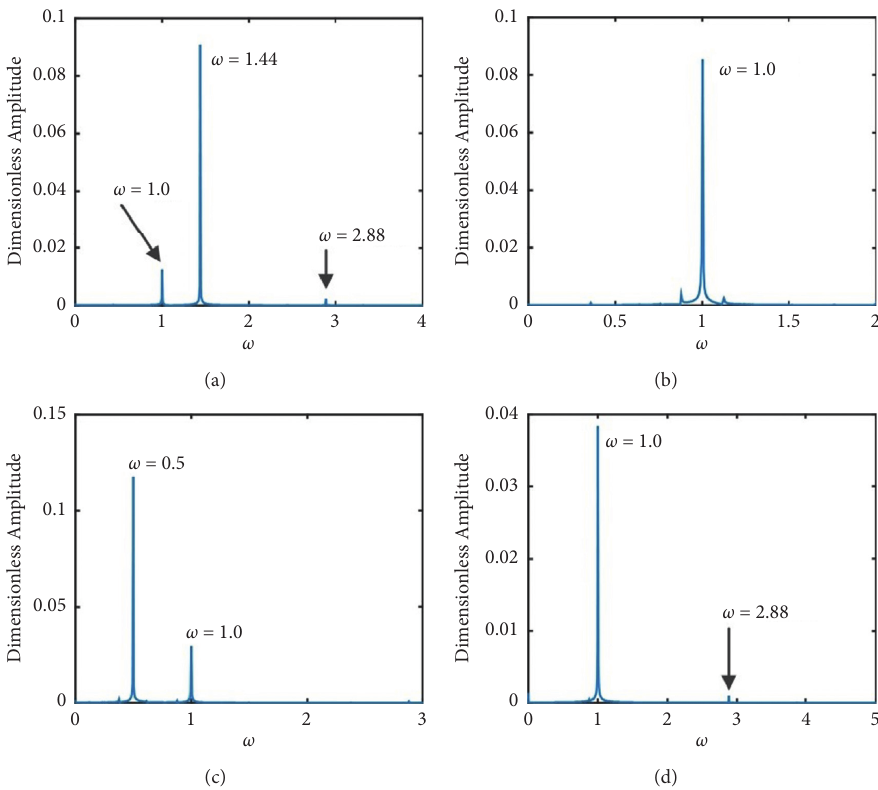
Figure 4: The amplitude-frequency curves of responses of left-end journal in horizontal direction when N installed, solid line means the SFD is mounted, blue means run-up process, and brown means run-down process).